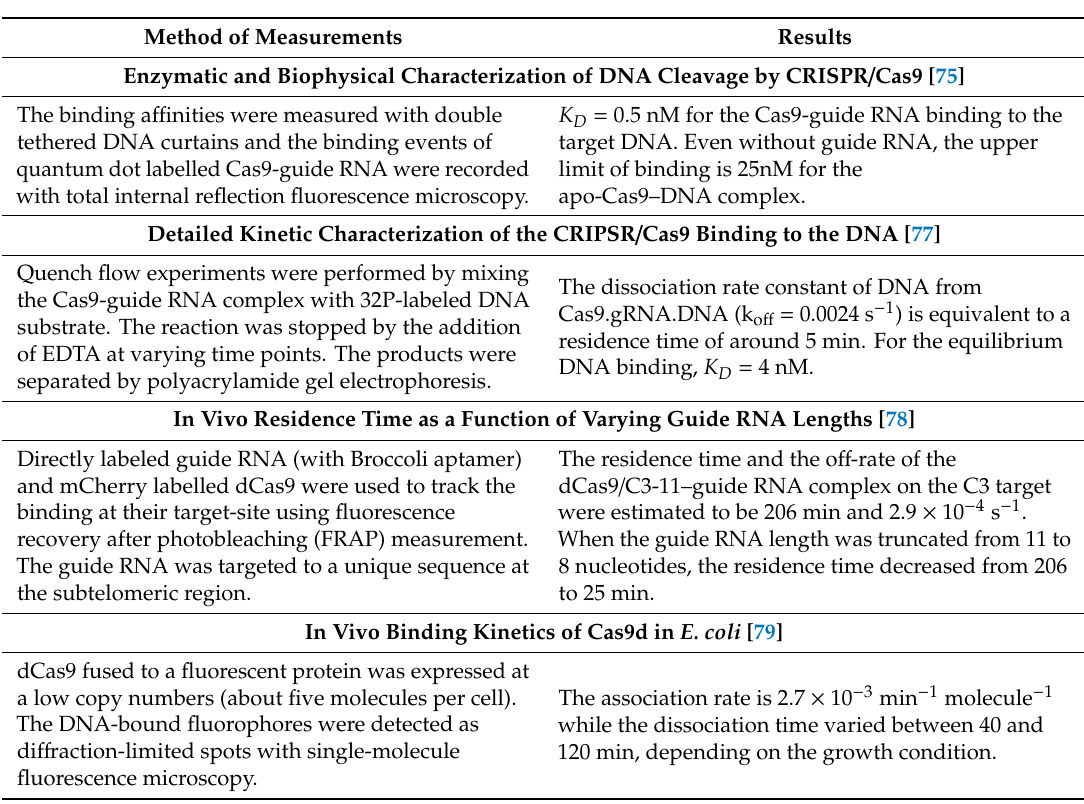
Table 4. CRISPR / Cas9